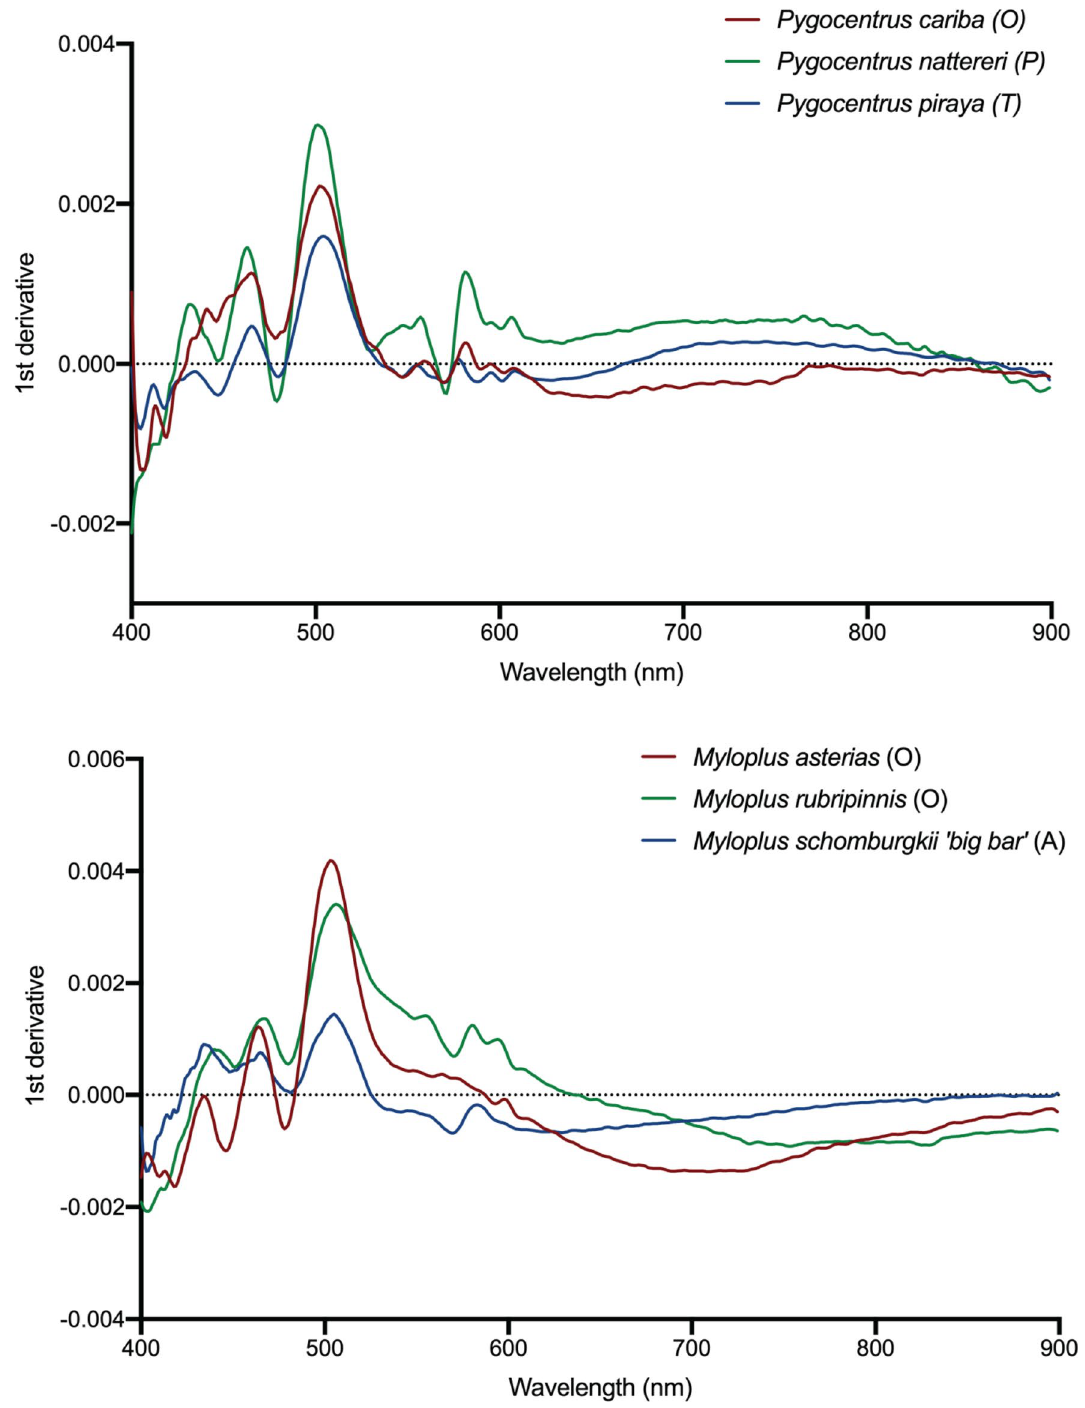
Figure 5. First derivative of the spectral signatures from three piranha ( a – c ) and three pacu ( d – f ) species shown in Fig.